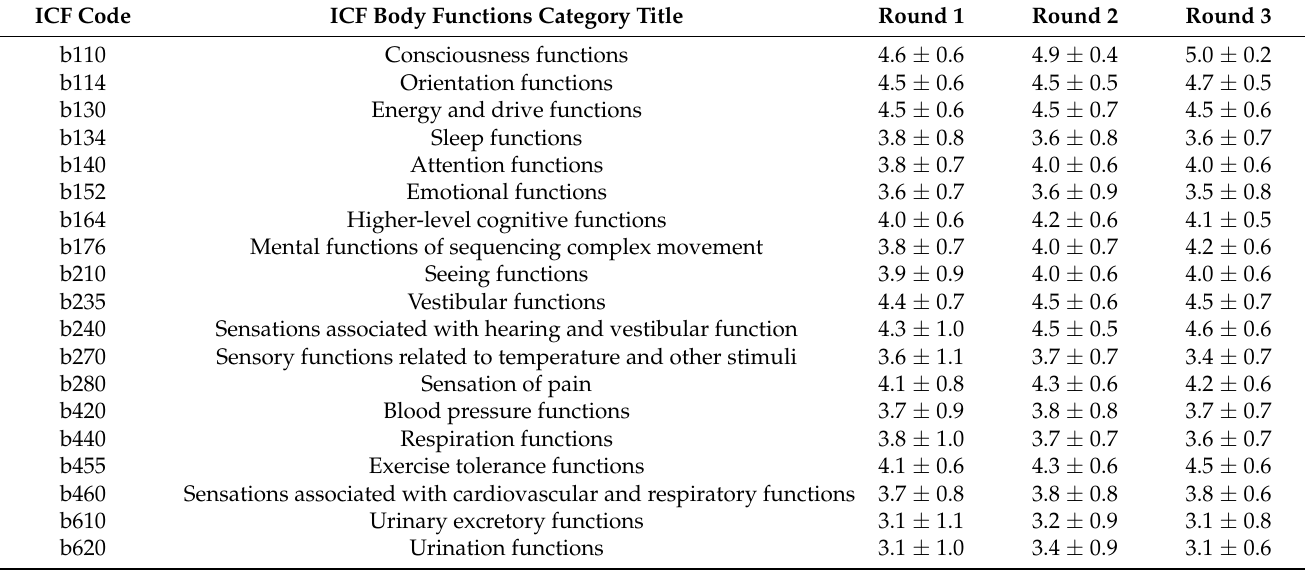
Table 1. Delphi Consensus rating scores of ICF body function categories for hip fracture